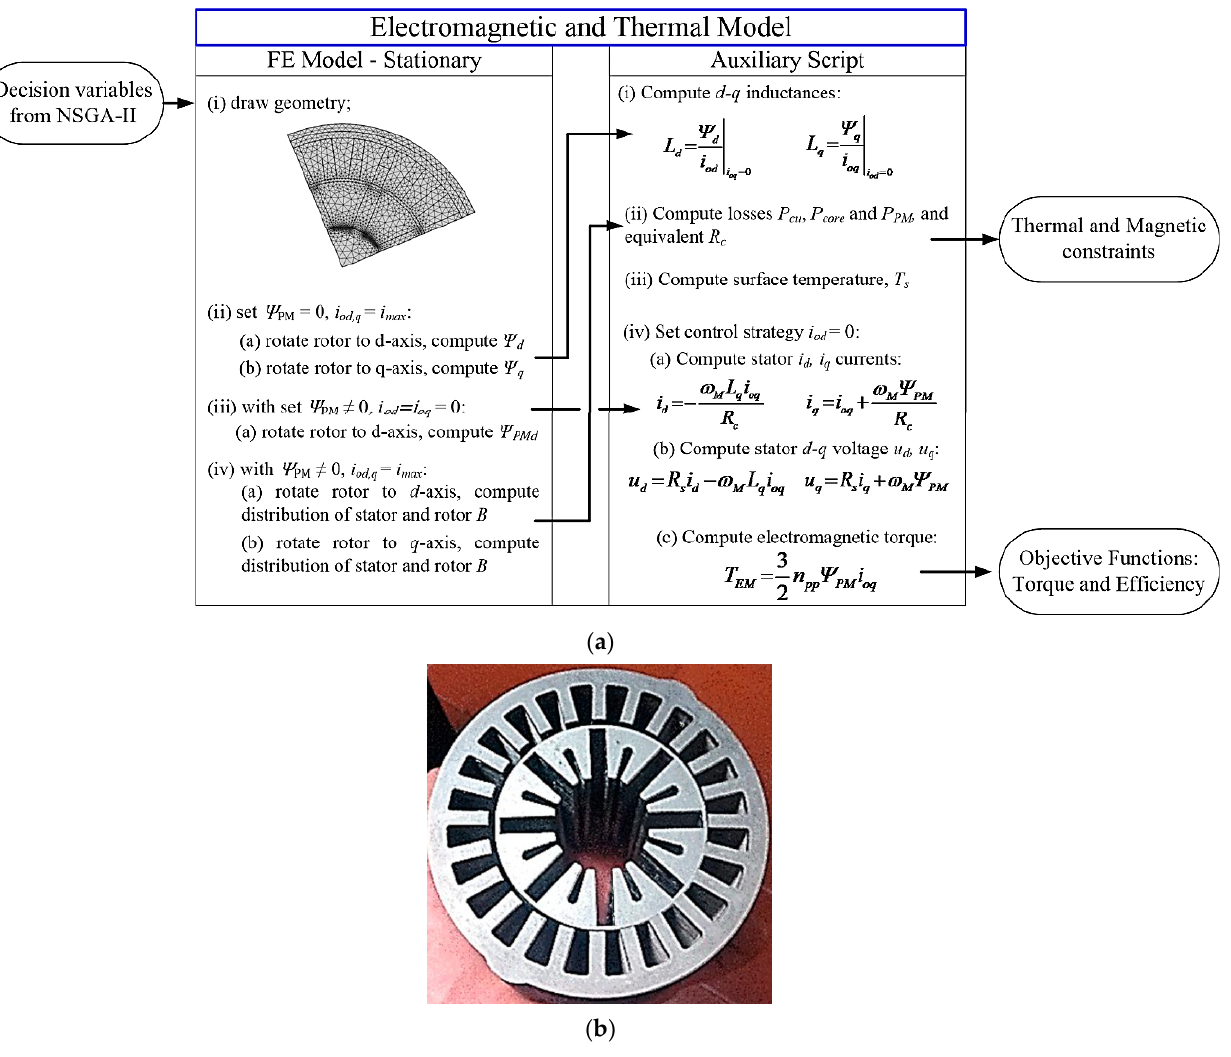
Figure 4. ( a ) Methodology used in [12], coupling an electromagnetic FEM stationary model plus a lumped-parameter magnetic and thermal model of the machine with a genetic multi-objective opti- mization (NSGA-II). ( b ) The magnetic core of the final PMSM prototype manufactured in